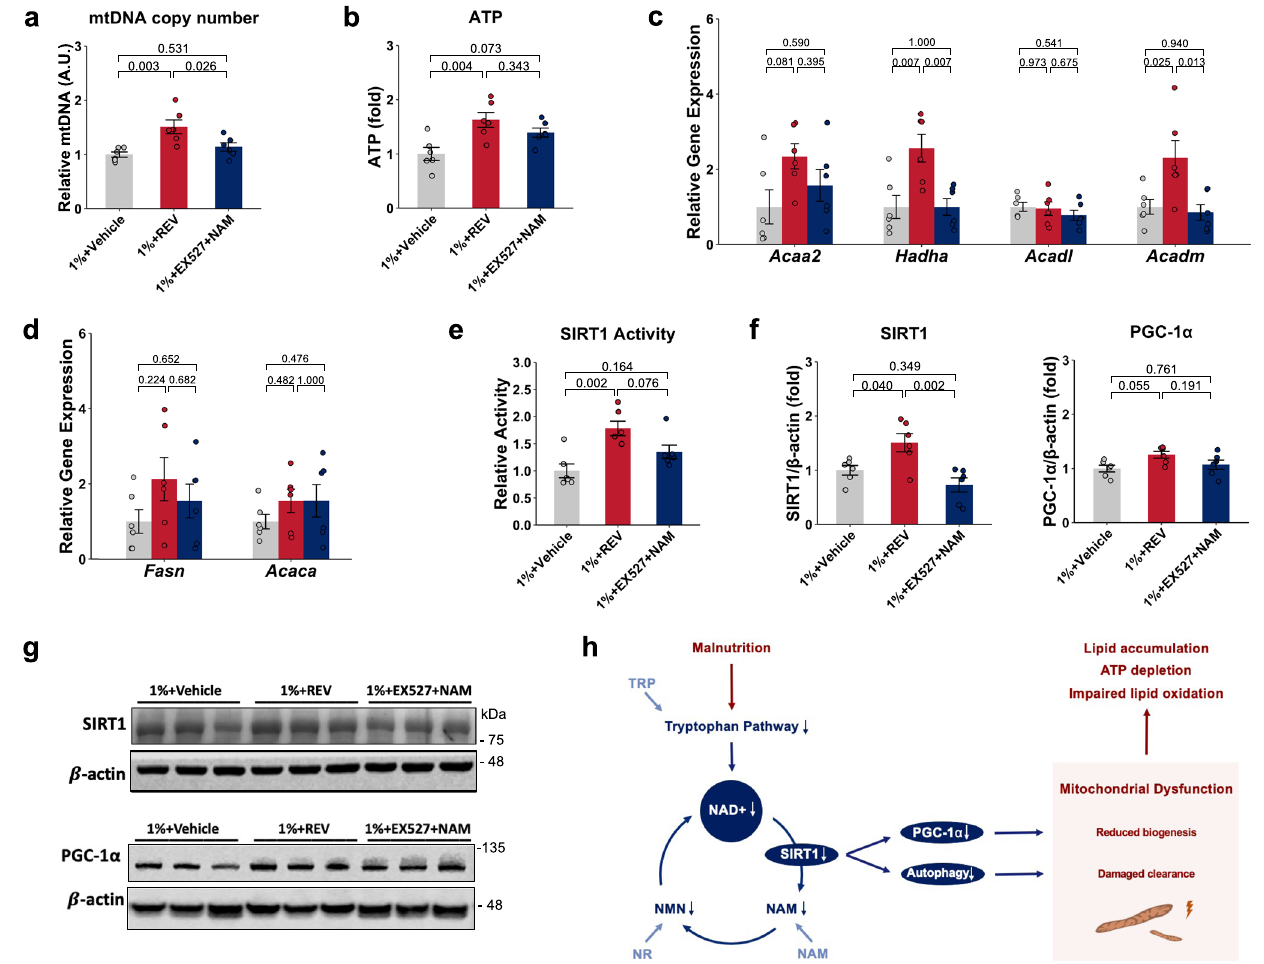
Fig. 7 | The effect of SIRT1 modulators on hepatic steatosis, mitochondrial characteristics, SIRT1, and its downstream targets. a Relative mtDNA copy number (mtDNA/beta-globin) ( n =6 per group). b ATP levels ( n =6 per group). c Relative expression of β -oxidation genes ( n =6 per group). d Relative expression of lipid genesis genes ( n =6 per group). e SIRT1 activity ( n =6 per group). g Quanti fi cation of SIRT1 and PGC-1 α protein levels in western blots ( n =6 per group). f RepresentativeSIRT1andPGC-1 α